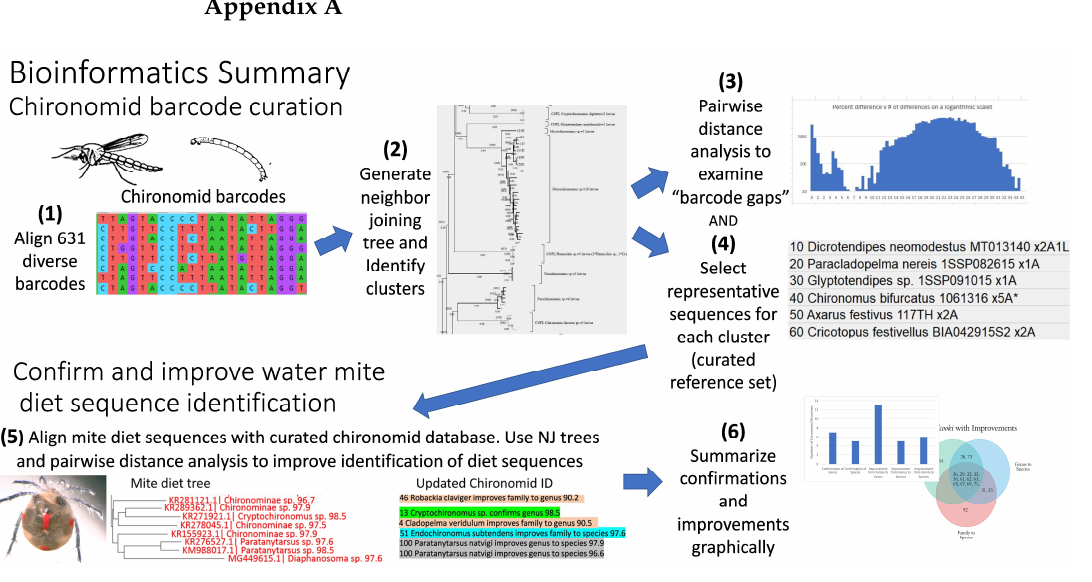
Figure A1. Graphical summary of